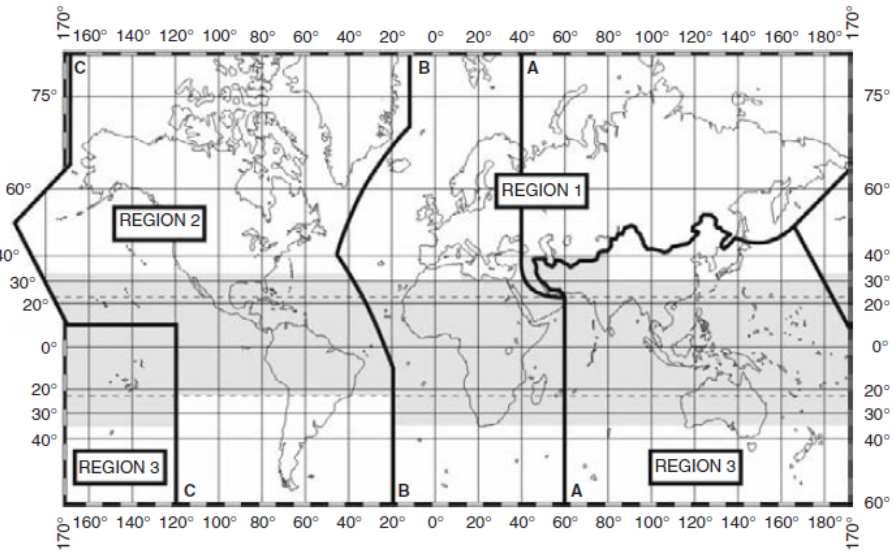
Figure 2. Division of the world into three geographical zones by ITU-R (Adapted from [5]).